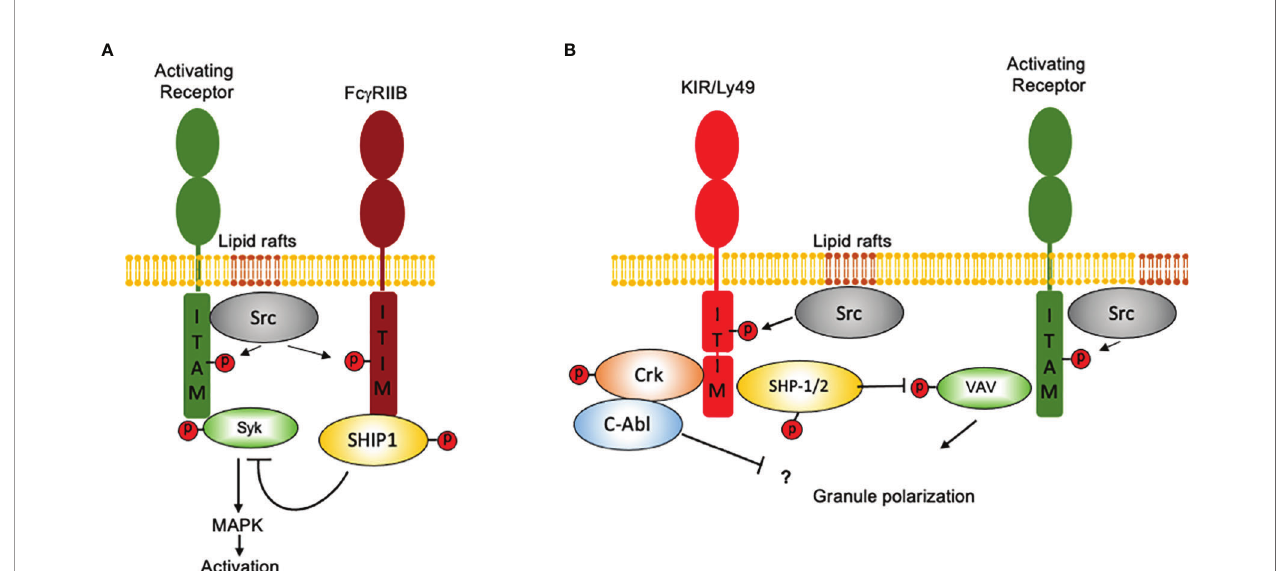
FIGURE 2 | How NK cells contributed to our idea of “ inhibition ” in the immune system. Inhibition in immune cells is based on the presence of ITIM-containing molecules and in the recruitment of SH2 domain-containing protein phosphatases. Although the presence of an ITIM sequence may represent a basic operation mode for inhibition, there are important differences in how signals are displayed downstream ITIM phosphorylation. For simplicity, only two major systems of inhibition are depicted. (A) The Fc g RIIB receptor binds a single-SH2 domain-containing phosphatidylinositol 5-phosphate (SHIP1). Activation of SHIP-1 leads to dephosphorylate various substrates downstream ITAM-containing receptors. Fc g RIIB coaggregation with activating receptors is mandatory to allow Src family kinases to phosphorylate both, the ITAMs and the ITIMs. (B) Inhibitory NK cell receptors bind a two-SH2 domain containing tyrosine phosphatase (SHP1/2). ITIM- containing NK cell receptors are constitutively associated with Src family kinases and as consequence they can signal independently of activating receptors ligation However, coaggregation of an inhibitory NK cell receptor with activating ITAM-containing receptors is necessary to inhibit cell activation. For ITIM-containing NK cell receptors, Vav1 seems to be the only signaling protein associated with the catalytic site of SHP-1 upon recognition of target cells expressing HLA molecules. Moreover, NK cell inhibitory receptors seem to operate no only by promoting tyrosine dephosphorylation, since they are also able to promote the tyrosine phosphorylation of the adapter protein Crk and to promote its association with the tyrosine kinase